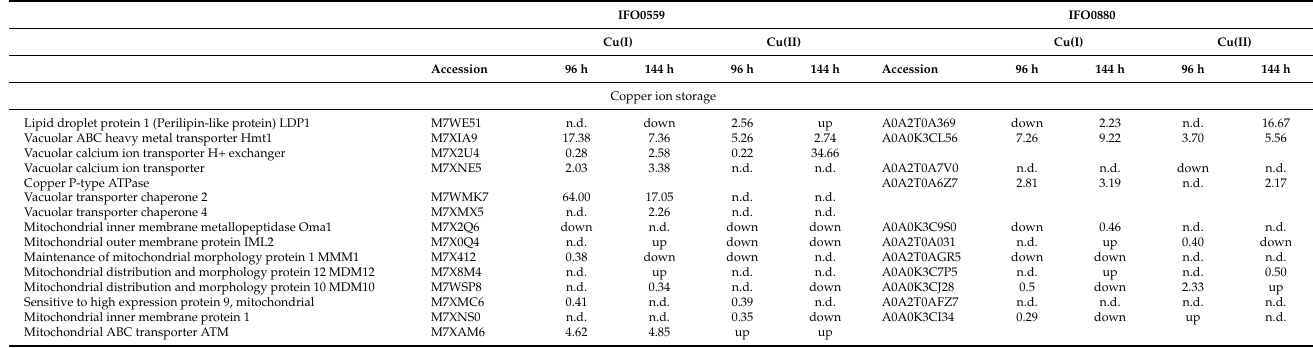
Table 4. Differentially expressed proteins involved in copper ion storage discussed here. For IFO0559 and IFO0880, fold change of samples grown under Cu(I) and Cu(II) stress was compared to respective control. Protein names and UniProt accession numbers are listed. Abbreviations are written in bold. Further fold change at 96 h and 144 h of samples are stated. Fractions below 1 depict downregulation. n.d. = not detected; up = upregulated below cut-off score; down = downregulated below cut-off score. Cut-off score: significance ≤ 2 or fold change ≤